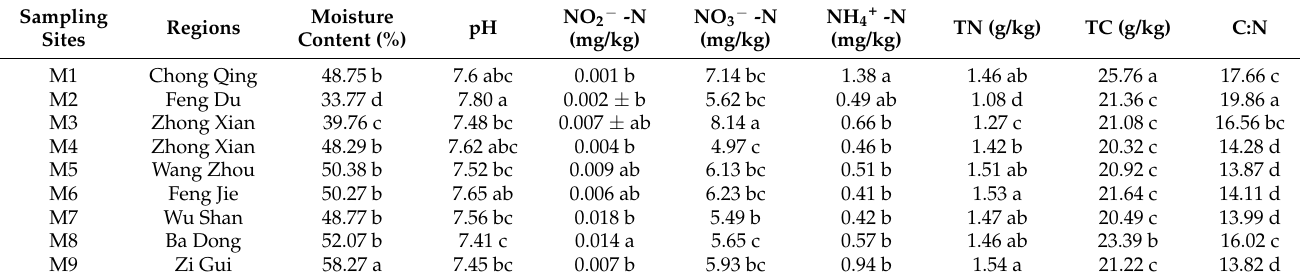
Table 1. The physicochemical properties of sediments.